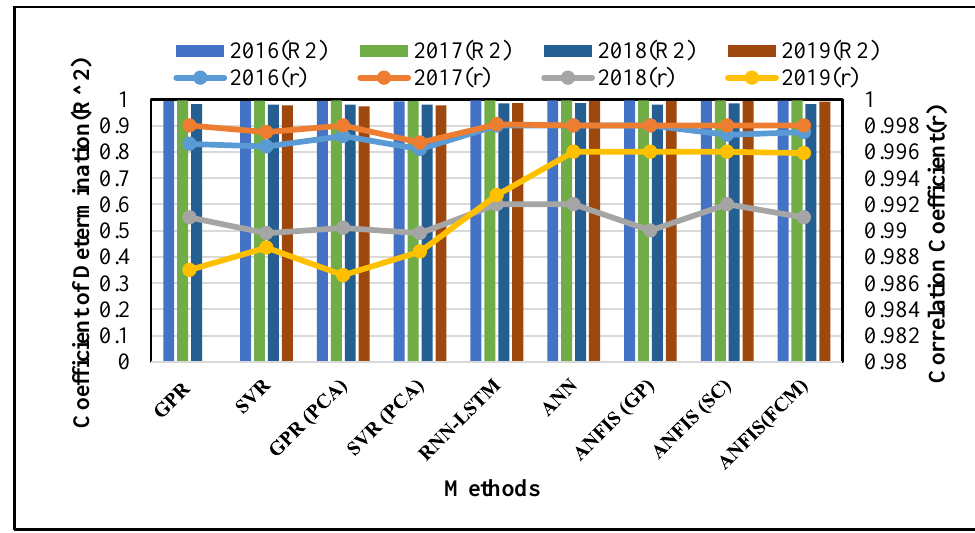
Figure 11. Comparison of RNN-LTSM test results of r and R 2 for m-si with other techniques over the period (2016–2019).